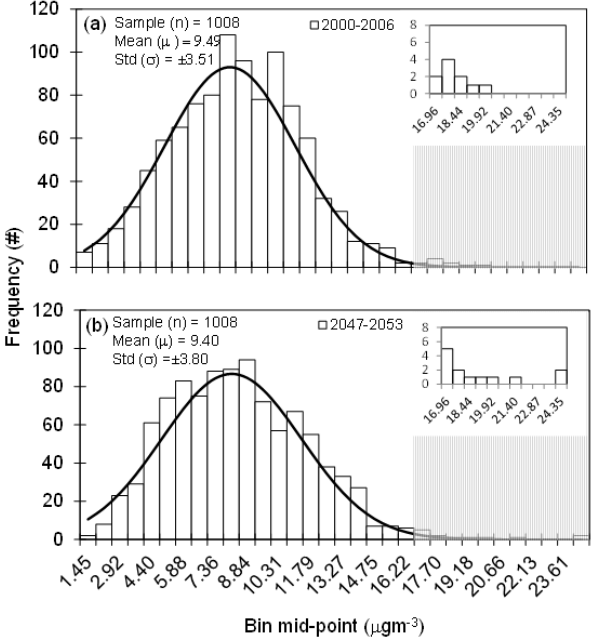
Fig. 3. Frequency distribution of 24-h average population-weighted PM 2 . 5 total mass concentrations for California under the (a) present-day (2000–2006) and (b) future (2047–2053) climate con- ditions. The shaded regions encompass values higher than the 99th percentile value of each distribution, and insets show details of the shaded regions in the